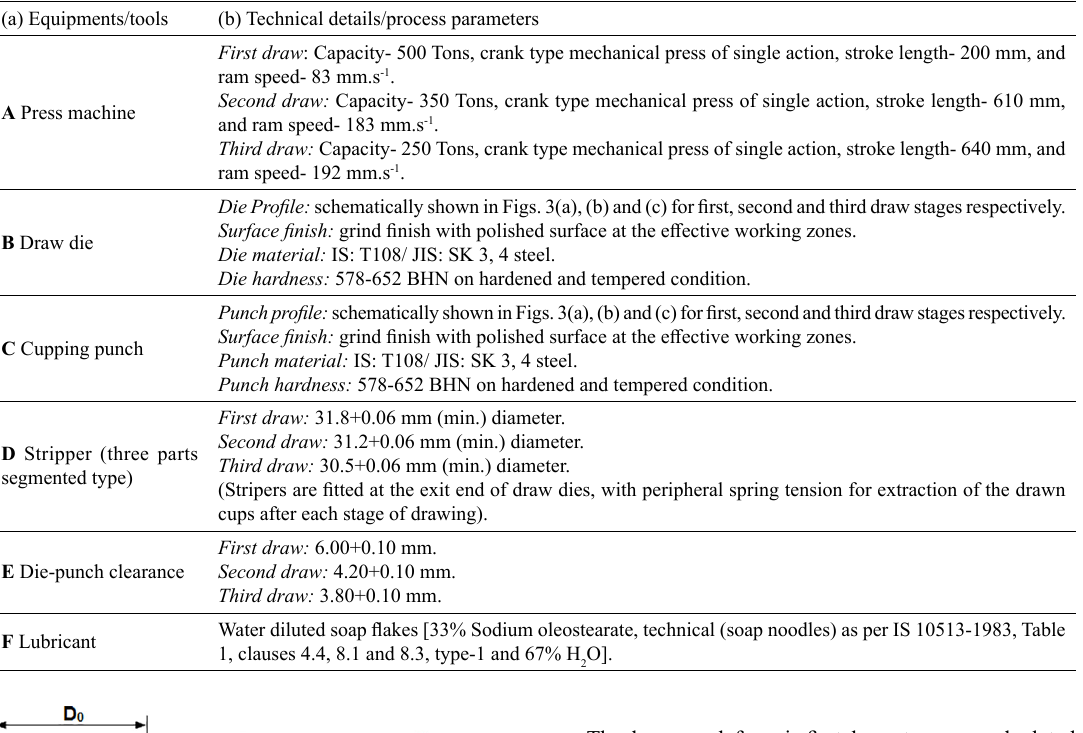
Table 2. Equipments, tools and process parameters used in 3-stage cup drawing operations. (a) Equipments/tools (b) Technical details/process parameters